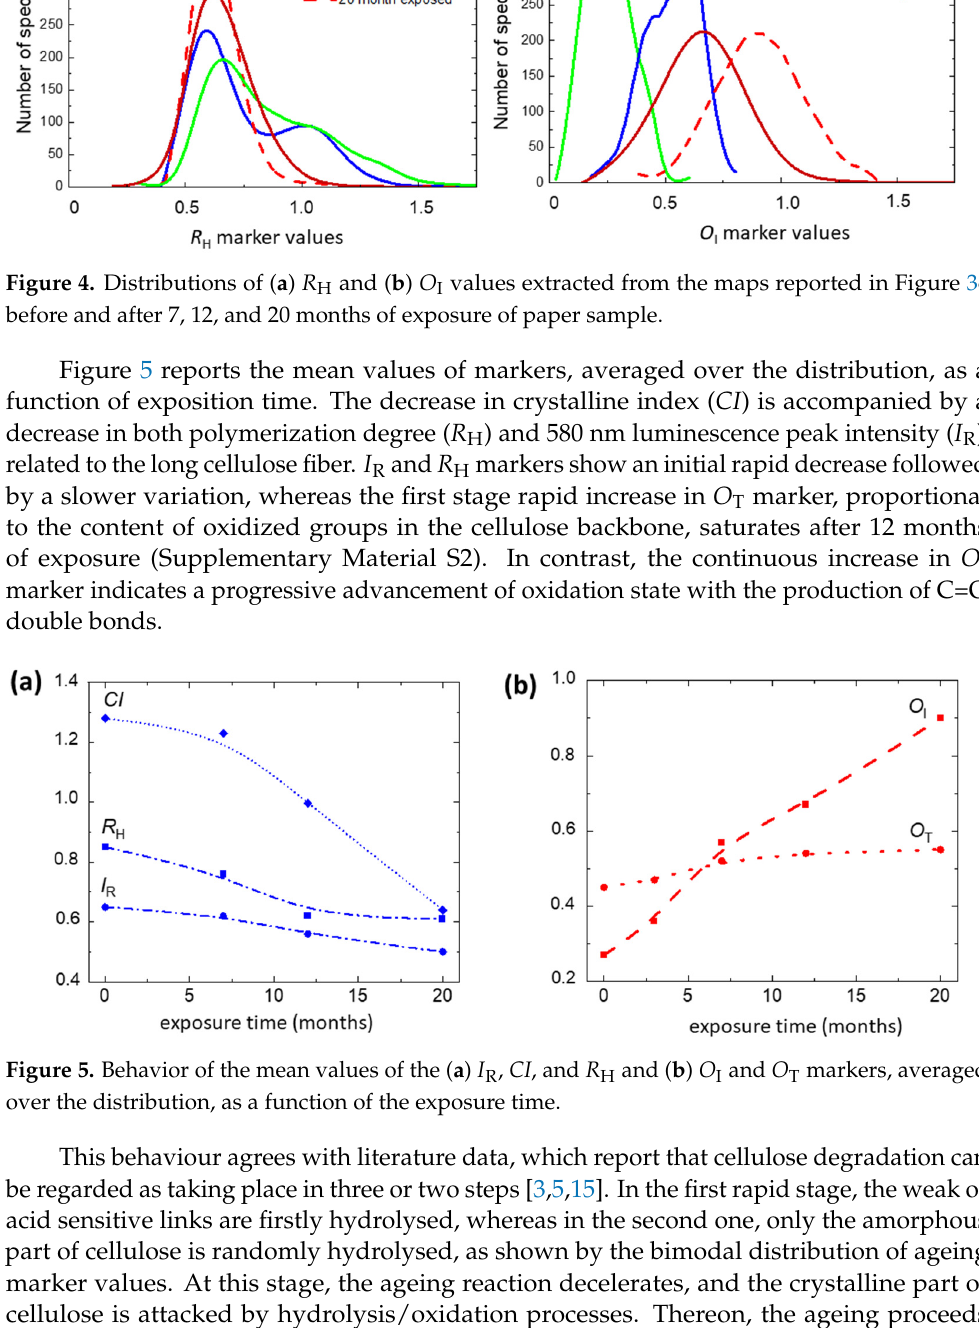
6 of 13 Figure 3. ( a ) White light optical image (objective 100×) of 60 × 60 μ m 2 of non-exposed paper sample area selected for spectra acquisition. Maps from 2D spectral arrays of (30 × 30) complete Raman/lu- minescence spectra recorded in the spectral imaging mode and extracted using as contrast parame- ters ( b ) the ratio I R between the luminescence peak intensities and ( c ) the CI , R H , O I and O T markers from Raman spectra. The color code displays the increasing value in the sequence blue–red–yellow.